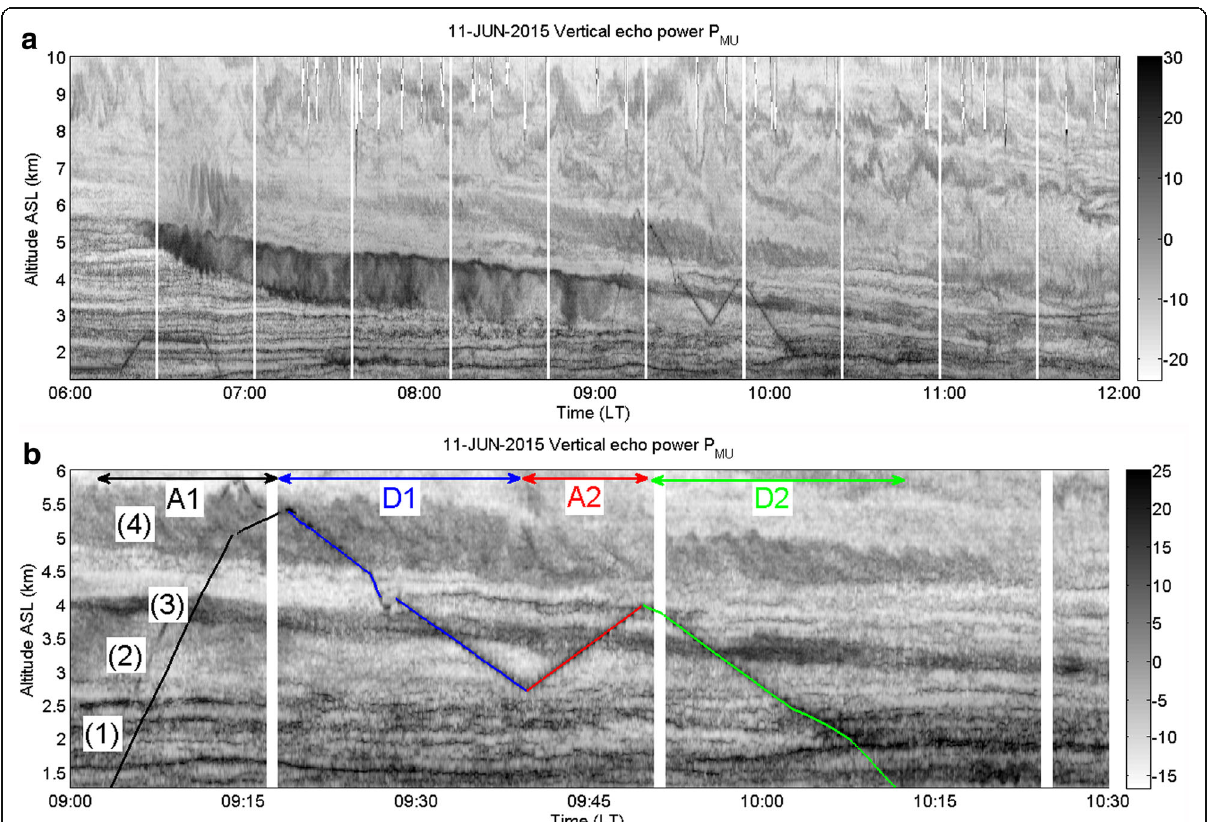
Fig. 5 a Same as Fig. 4c, but from 06:00 LT to 12:00 LT on June 11 in the height range 1.27 – 10.00 km. The gaps correspond to radar stops. A KHI event and UAV 16 track can be seen between 06:00 and 07:00 LT. MCT starts around 06:20 and extends to 10:20 LT. UAV 17 track can be seen between 09:00 and 10:30 LT. b Close-up of Fig. 5a from 09:00 LT to 10:15 LT on June 11 in the height range 1.27 – 6.00 km. Superimposed curves show the height of UAV 17 vs. time ( Black line for A1, blue for D1, red for A2, and green for D2). The labels (1) to (4) refer to the regions discussed in the